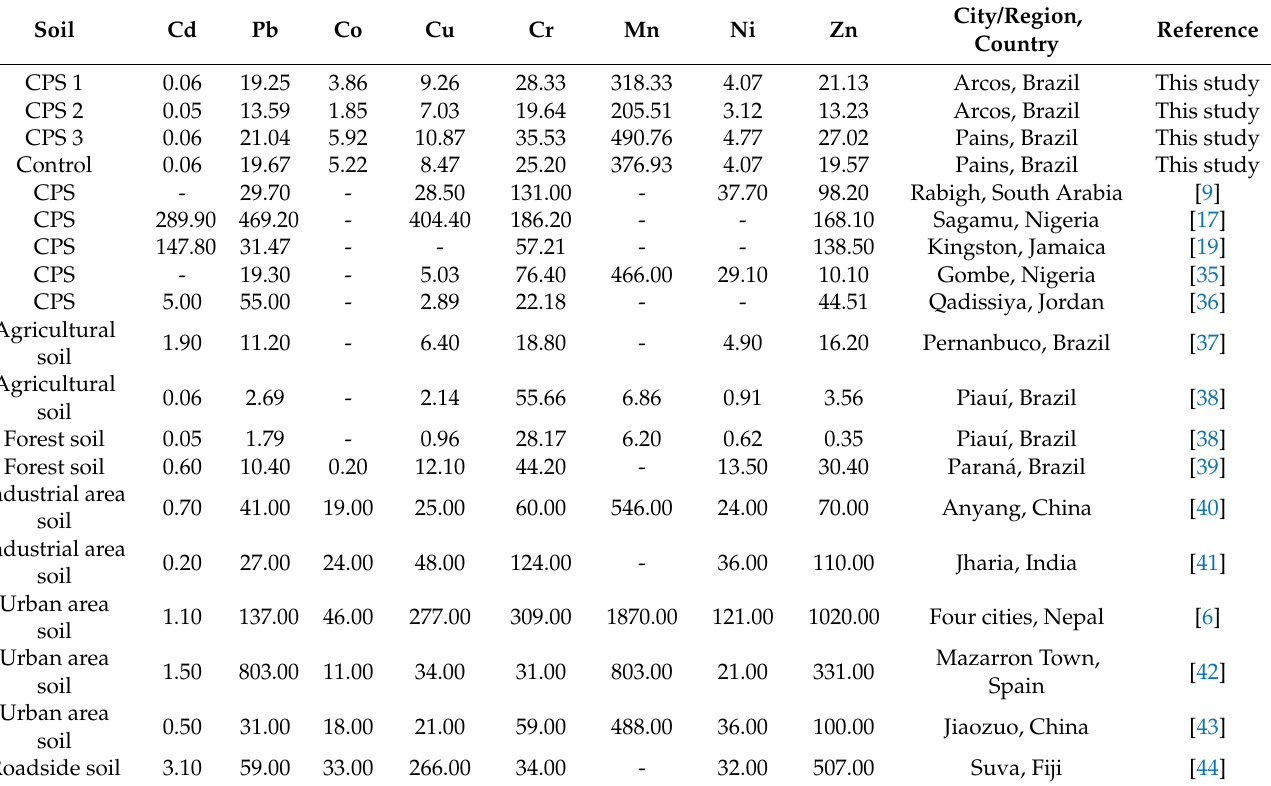
Table 2. PTM concentrations in soil samples from this study and cities worldwide